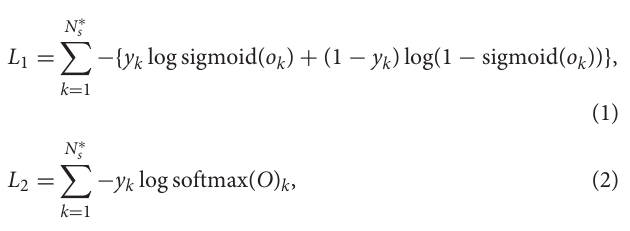
Frontiers in Big Data |